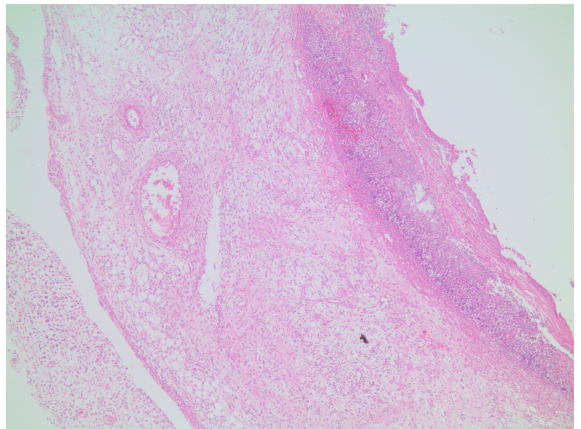
Figure 6. Combined group on day 7, extensive and deep ulceration and fibrosis (H&E, × 40). H&E, hematoxylin and